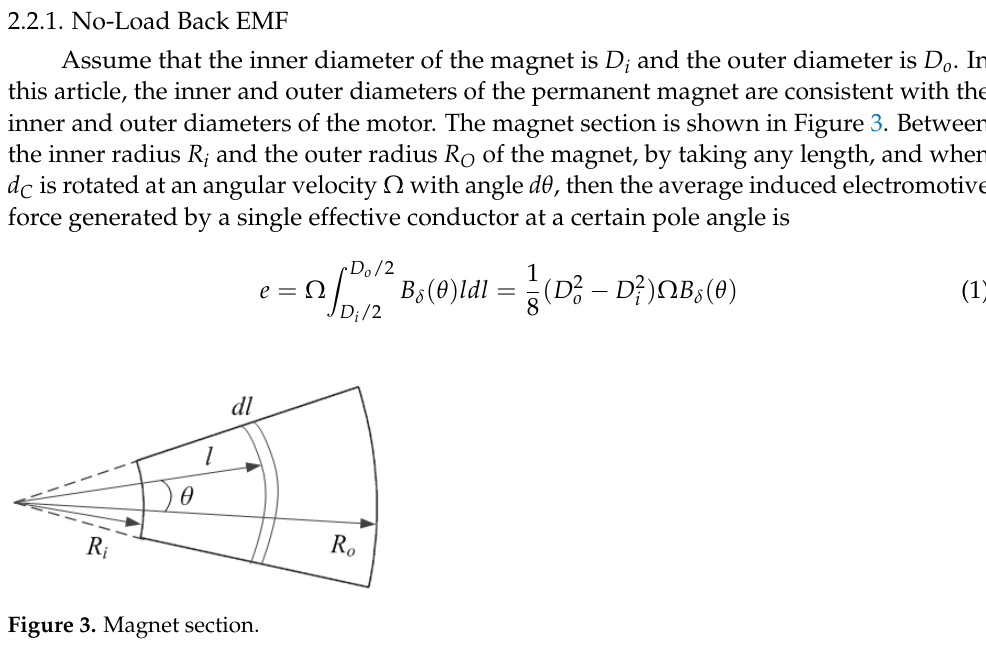
Figure 3. Magnet section.